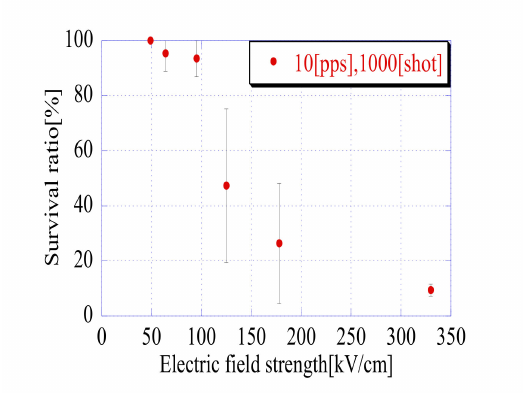
Figure 20. Survival ratio of E. coli for the electric field strength of the center of the bottom in the hollow in configuration